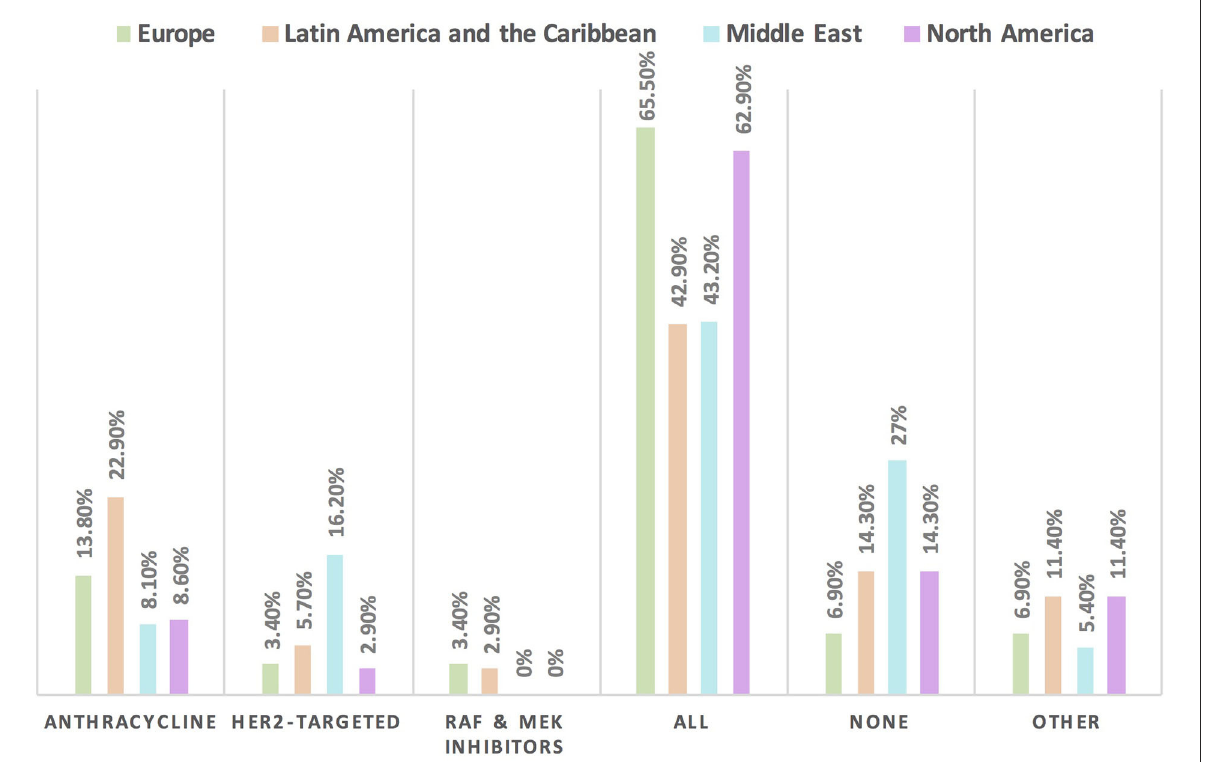
FIGURE2 Frequency of using HFA/IC-OS proformas for baseline CVD risk stratification in cardio-oncology in different continents. The highest rate for the use of all HFA/IC-OS proformas for baseline cardiovascular risk stratification was found in Europe followed by North America. However, the largest proportion of physicians who do not use any of these proformas was found in the Middle East.